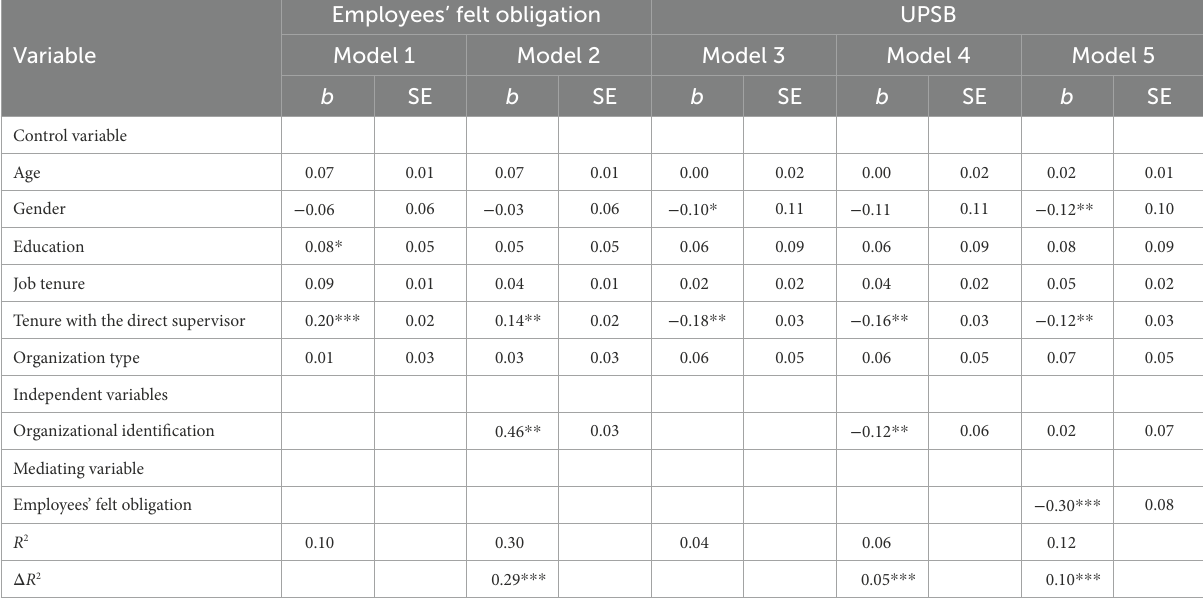
TABLE 3 The test of the mediating effect of employees’ felt obligation by causal stepwise